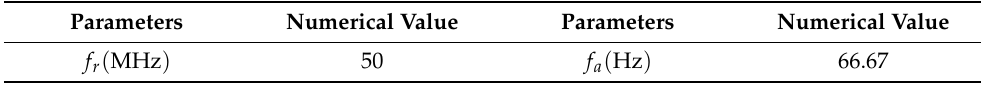
Table 2. Jamming simulation parameters.